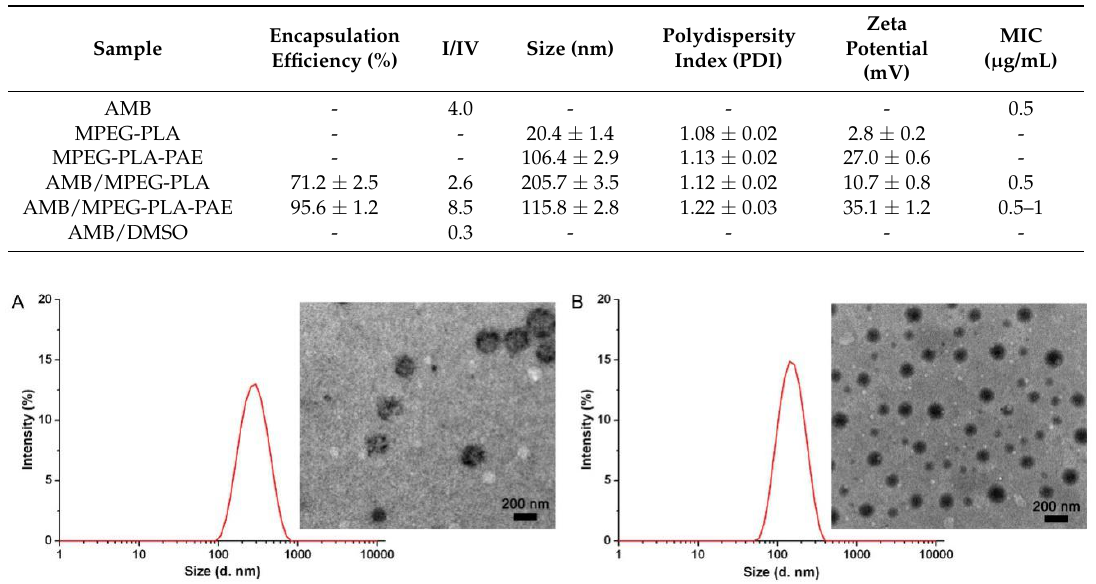
Table 1. Characterization of each formulation.